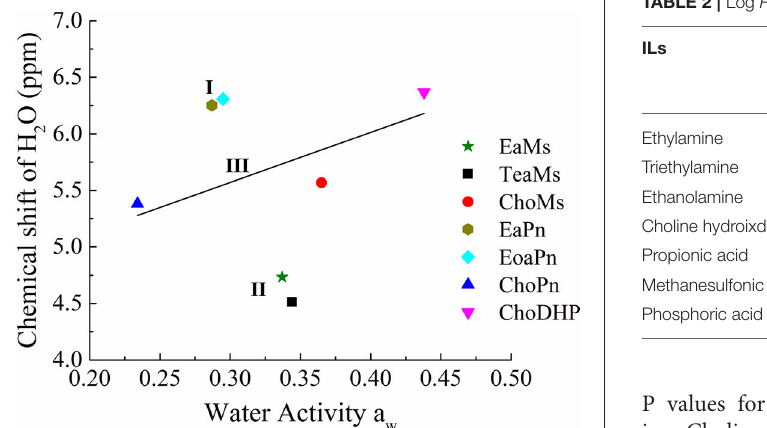
TABLE 2 | Log P -values of the conjugated base and acid of ILs in this